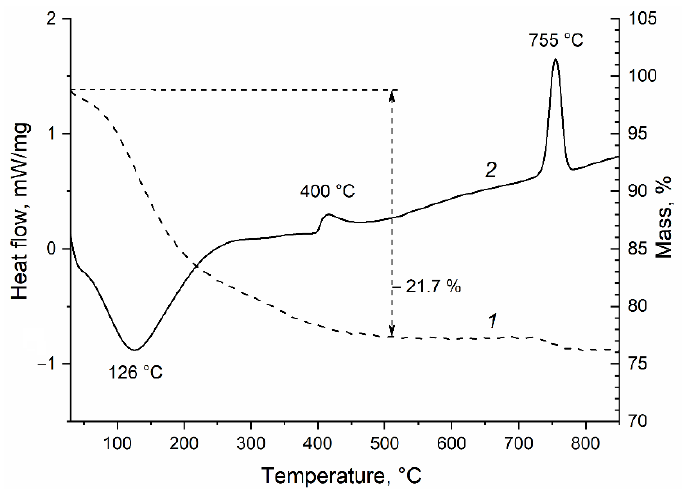
Figure 5. Thermogravimetry ( 1 ) and differential scanning calorimetry ( 2 ) curves of the separated fine powder when heated in nitrogen.